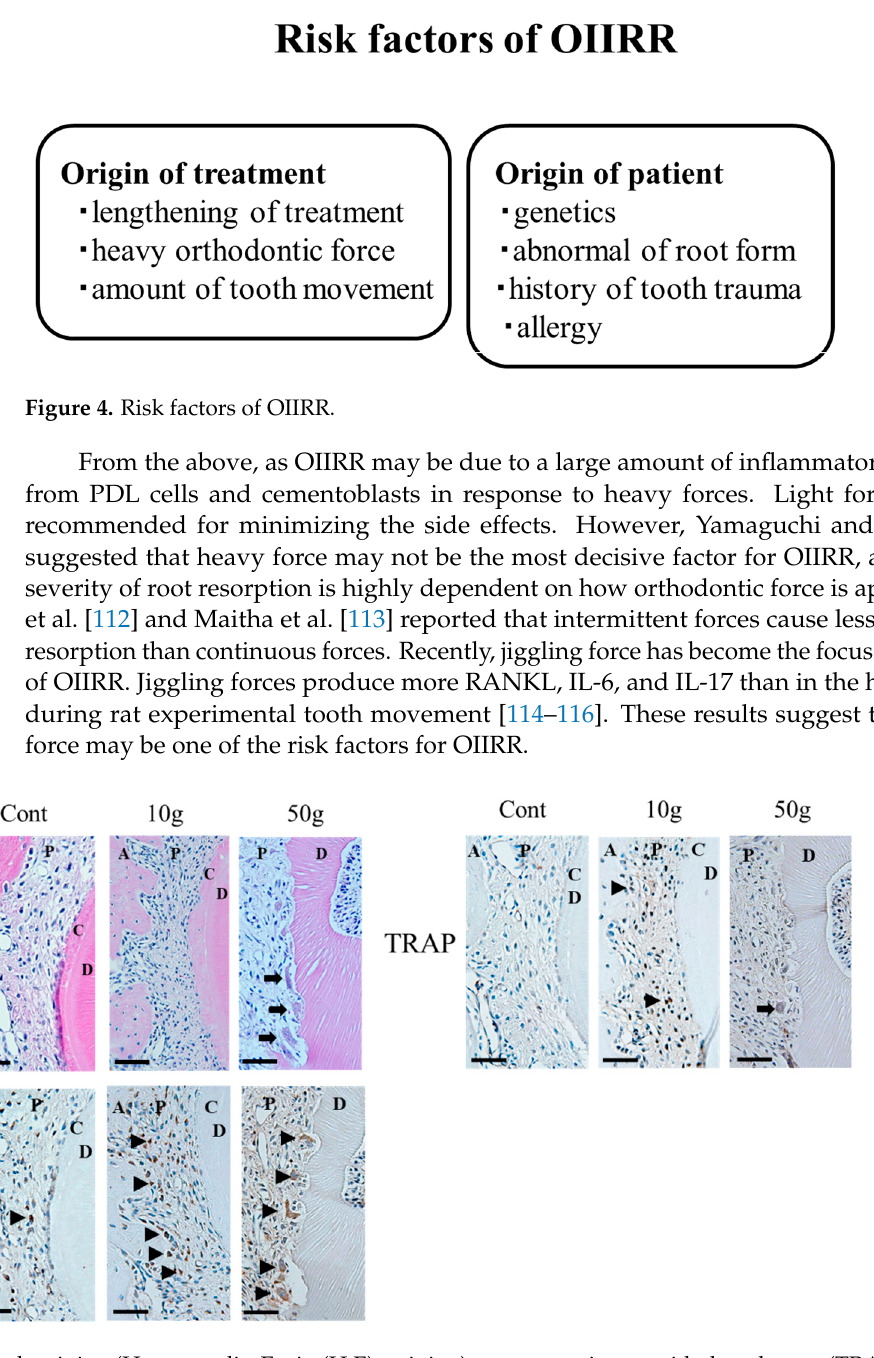
Figure 5. Histopathological staining (Hematoxylin-Eosin (H.E) staining), tartrate-resistant acid phosphatase (TRAP), and Receptor activator of nuclear factor kappa-B ligand (RANKL) immunohistochemical staining during rat experimental tooth movement after 7 days (performed by Yamaguchi M). In the 10 g group after 7 days, RANKL positive cells were observed in the bone resorption pit of the alveolar bone surface. In the 50 g group after 7 days, RANKL positive cells were observed in the root resorption pit. Bars: 50 µ m. A, alveolar bone; P, periodontal ligament; C, cementum; D, dentin. In the 10 g group RANKL positive cells (black triangle) were observed in the bone resorption pit of the alveolar bone surface. In the 50 g group, RANKL positive cells (arrow heads) were ob- served in the root resorption pit.